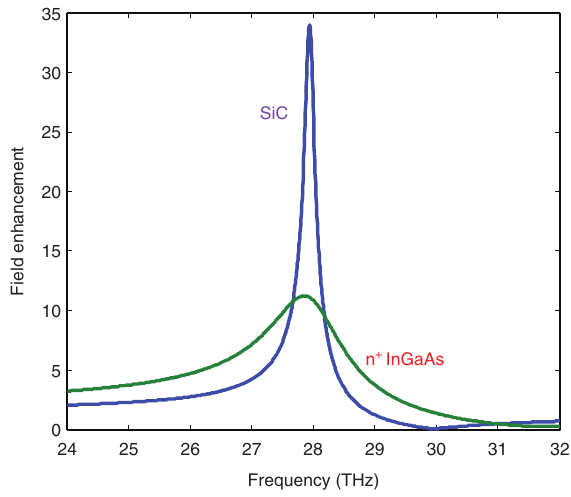
Figure 4: Maximum field enhancement provided by the 0.5 μ m spheres of SiC and n-doped